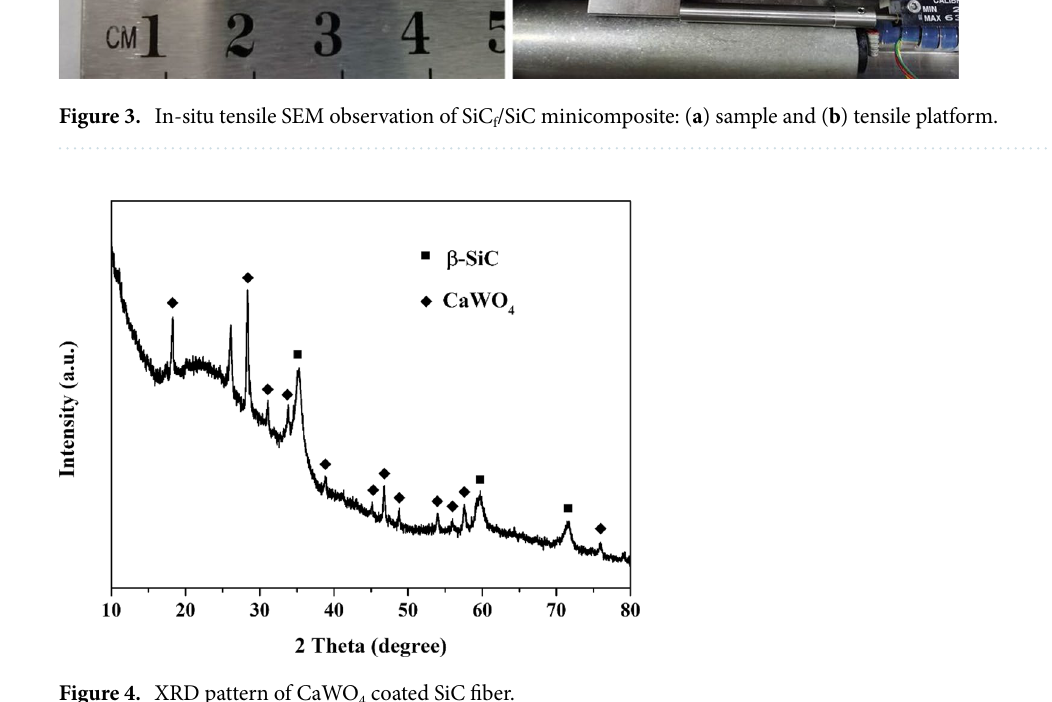
Figure 4. XRD pattern of CaWO 4 coated SiC